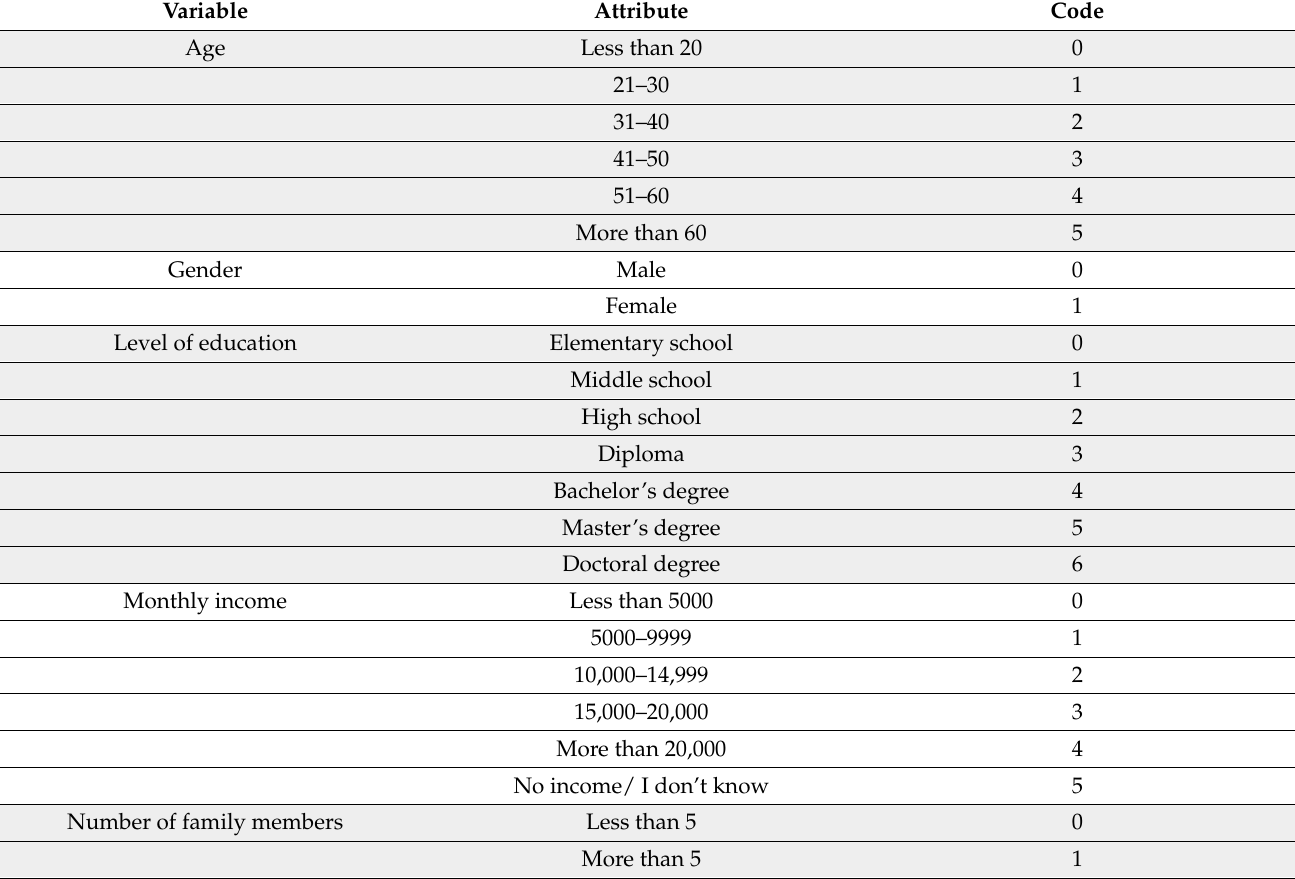
Table 3. Coded independent variables to be used for regression analysis.